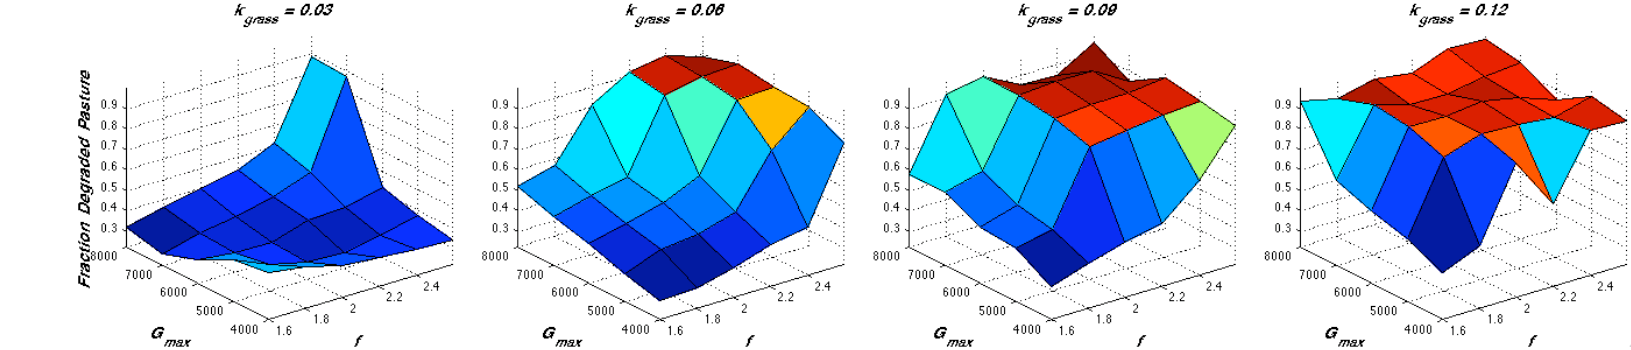
Figure A2.9: Fraction of property in degraded pasture across dimensions of grass capacity G grass growth rate k (/t). Individual surfaces show degraded pasture fraction as a function of grass capacity and stocking factor f at a constant grass intrinsic grass growth